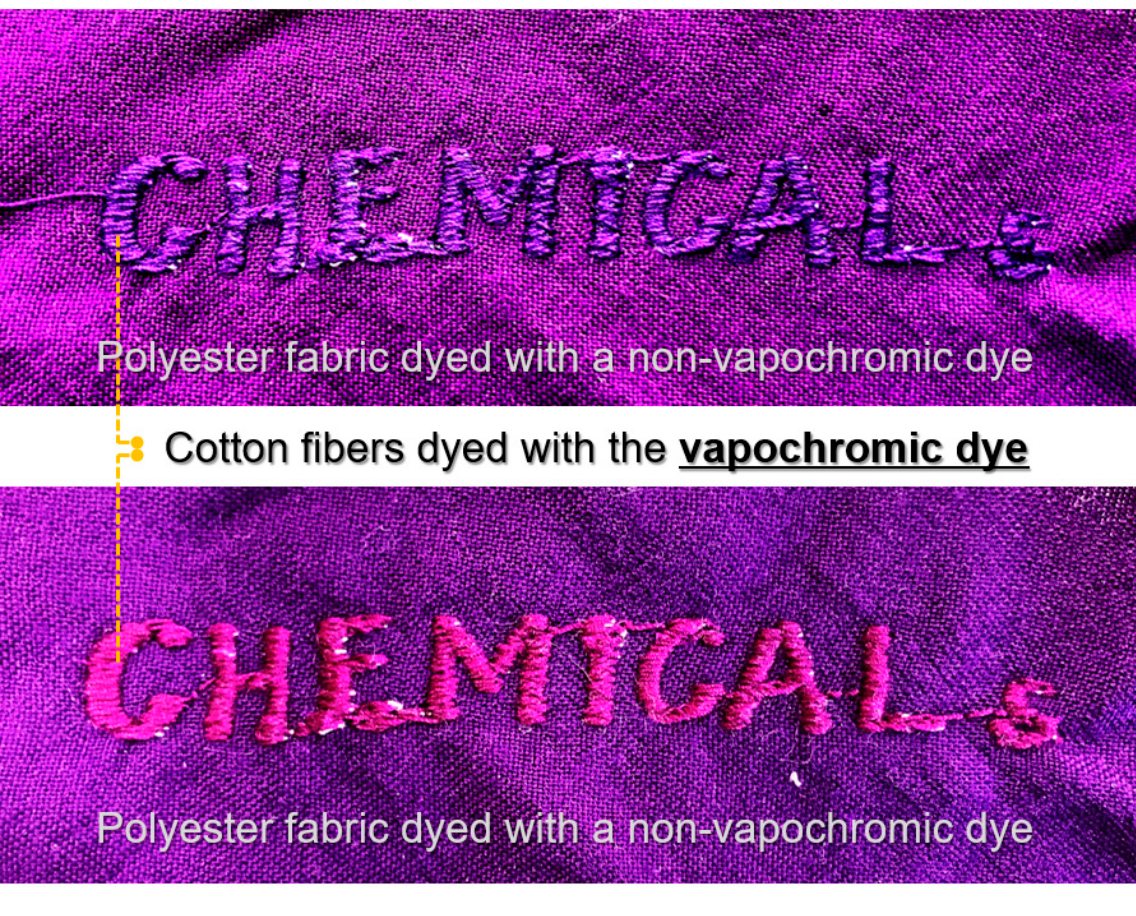
Figure 6. Visualization of the concept of textile-based vapor